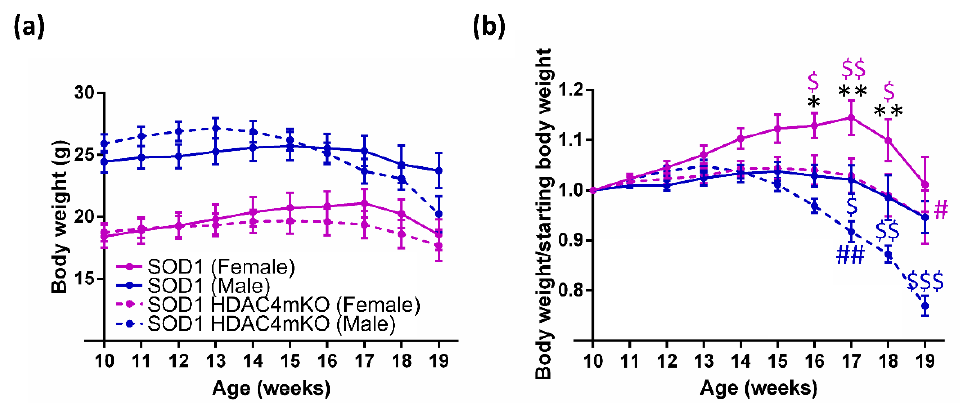
Figure 1. Sex and HDAC4 influence body weight in SOD1 mice. ( a ) Body weight of female and male SOD1 and SOD1 HDAC4mKO mice. Data are expressed as average +/- SEM; n = 10/13 females and n = 14 males for each time point. Two-way repeated measures ANOVA reveals a significant effect for time ( p < 0.0001), genotype ( p < 0.0001), and a significant interaction ( p < 0.0001); p < 0.005 female SOD1 vs. male SOD1; p = 0.0001 female SOD1 HDAC4mKO vs. male SOD1 HDAC4mKO mice, by Tukey’s multiple comparisons test. ( b ) Body weight of female and male SOD1 and SOD1 HDAC4mKO mice, normalized to the body weight at 10 weeks. Data are expressed as average +/- SEM; n = 10/13 females and n = 14 males for each time point. Two-way repeated measures ANOVA revealed a significant effect for time ( p < 0.0001) and for genotype ( p = 0.001), and a significant interaction ( p < 0.0001): $ p < 0.05, $$ p < 0.005, $$$ p < 0.0001. Male SOD1 vs. male SOD1 HDAC4mKO mice, as well as female SOD1 vs. female SOD1 HDAC4mKO mice: * p < 0.05, ** p < 0.005. Female SOD1 vs. male SOD1 mice: # p < 0.05, ## p < 0.005. Female SOD1 HDAC4mKO vs. their body weight at 10 weeks, or male SOD1 HDAC4mKO vs. their body weight at 10 weeks, were evaluated by Tukey’s multiple comparisons test.